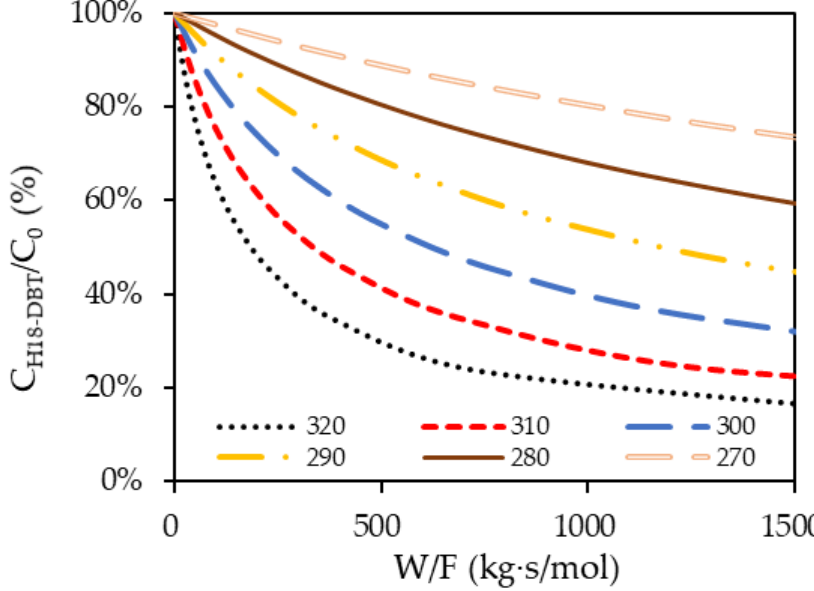
Figure 12. Effect of W/F on the ratio of the final molar concentration and initial molar concentration at different temperatures.